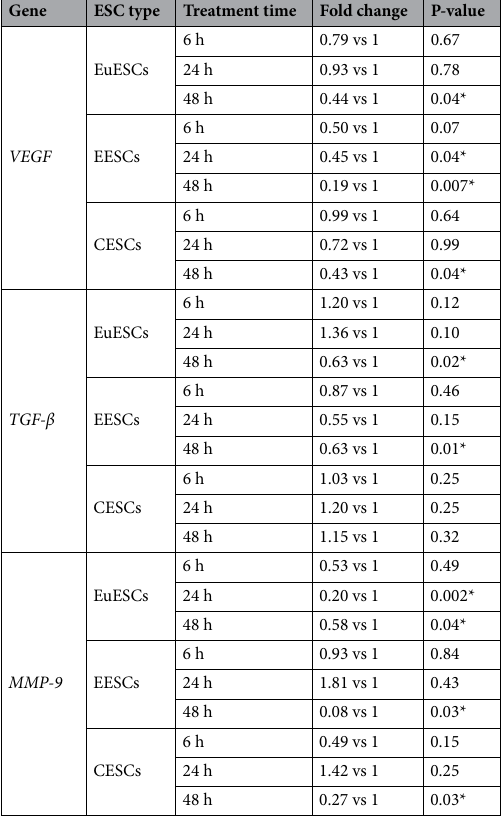
Table 2. The effect of resveratrol on VEGF, TGF-β and MMP-9 gene expression in ESCs. ESCs from endometriotic women (8 EESCs and 13 EuESCs) and non-endometriotic controls (11 CESCs) were cultured with or without 100 µM resveratrol. After 6, 24, and 48 h, the gene expression of VEGF, TGF-β and MMP-9 were examined using real-time PCR. Data were analyzed by non-parametric tests. *P-value < 0.05 is statistically significant. VEGF: Vascular endothelial growth factor, TGF-β: Transforming growth factor-β, MMP-9: Matrix metalloproteinase-9, ESCs: Endometrial stromal cells, EuESCs: Eutopic endometrial stromal cells, EESCs: Ectopic endometrial stromal cells, CESCs: Control endometrial stromal